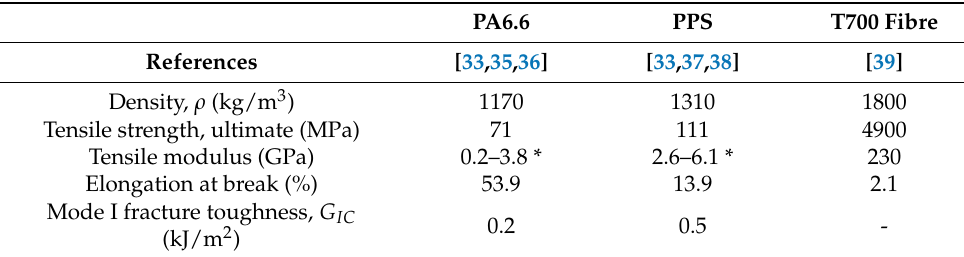
Table 1. Mechanical properties of neat PA6.6, PPS, and T700